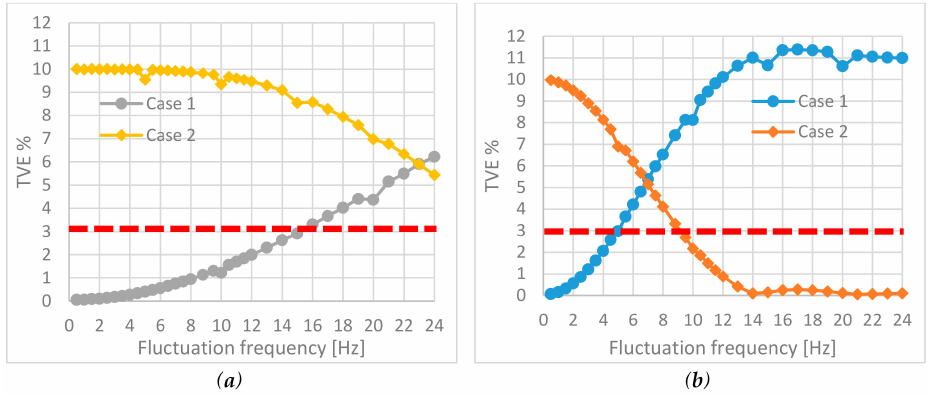
Figure 6. TVE results for PMU A with P ( a ) and M ( b ) configuration.